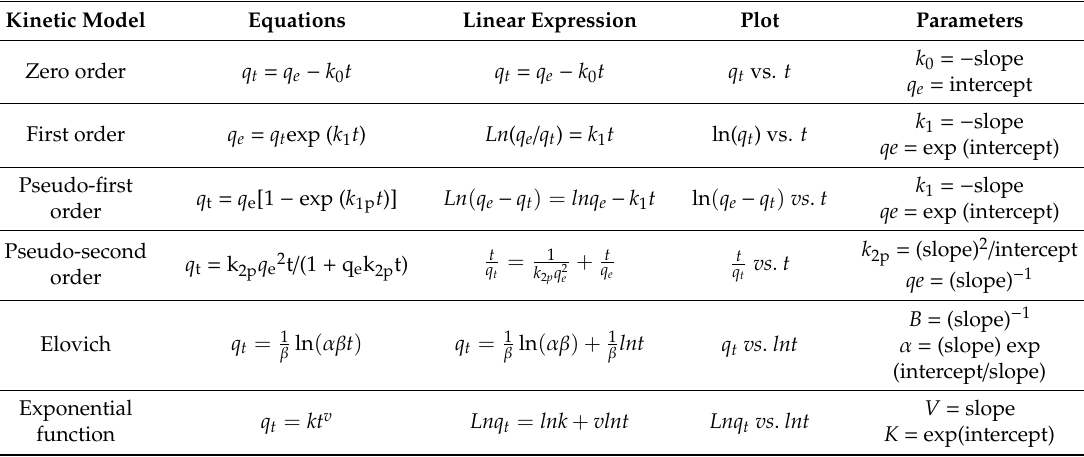
Table 3. Kinetic models and their linearized